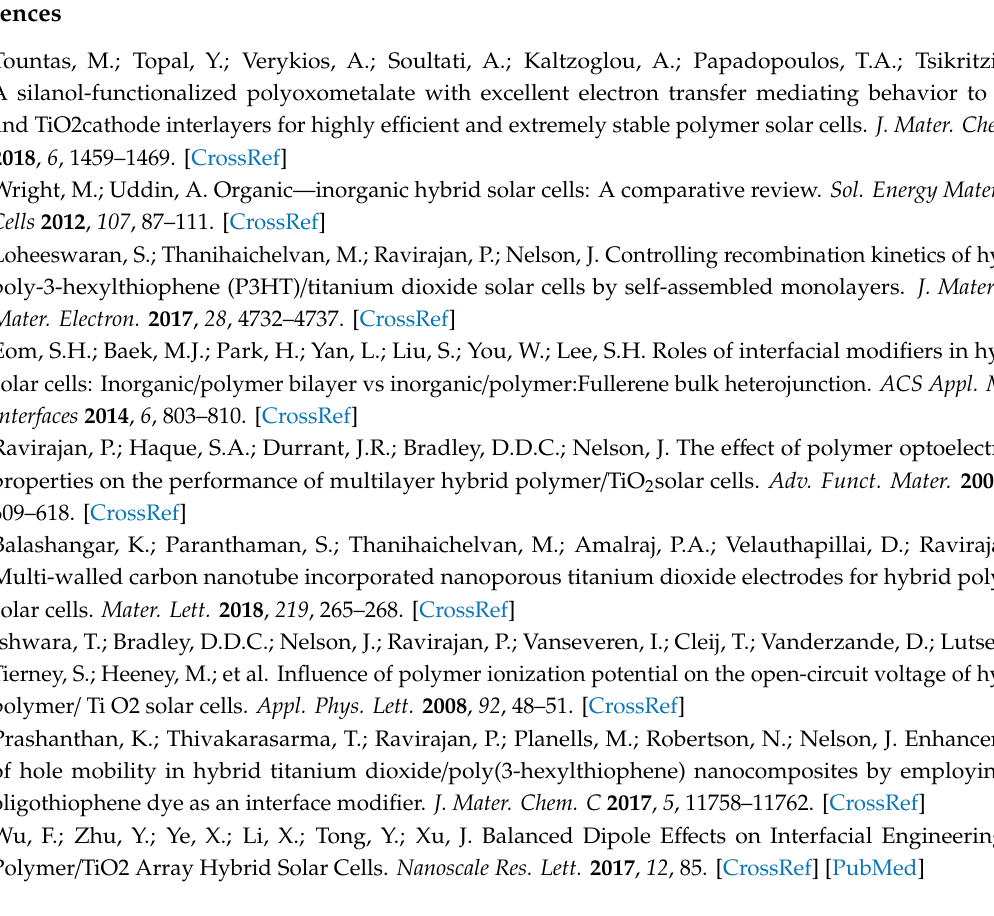
Figure SM1: Cross sectional FESEM image for fabricated TiO 2 / 4T / P3HT solar cell. The thickness of ITO layer was found to be 201.2 nm, Figure SM2: Cross sectional FESEM image for fabricated TiO 2 / 4T / P3HT solar cell with individual thickness for each layer, Figure SM3: Cross sectional FESEM image for fabricated TiO 2 / 4T / P3HT solar cell. The thickness of P3HT layer was found to be 177.7 nm, Figure SM4: Cross sectional FESEM image for fabricated TiO 2 / 4T / P3HT solar